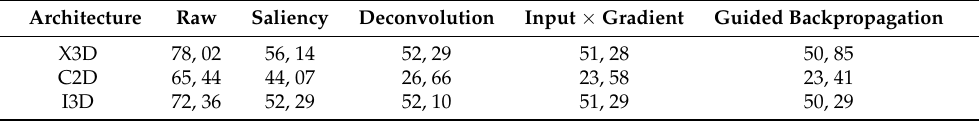
Figure 5. Temporal analysis. This example shows an example of the temporal analysis. Each row show the frame occlude though each interpretability method used. Table 4. Results of the temporal analysis on the test set. This table presents the f-measure value for each model evaluated in the test set based on the sanity-check analysis. The column architecture represent the model evaluated while the saliency, deconvolution, input × gradient, and guided back- propagation represents the results obtained from the sanity check with the respective interpretability method. The column raw is the baseline results.